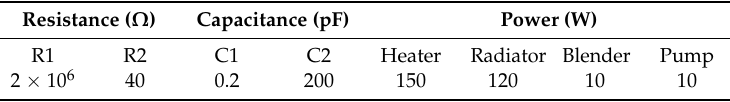
Table 1. Parameters of high voltage generation